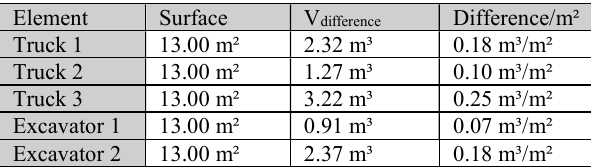
Table 4: The influence of material and machinery on the volume